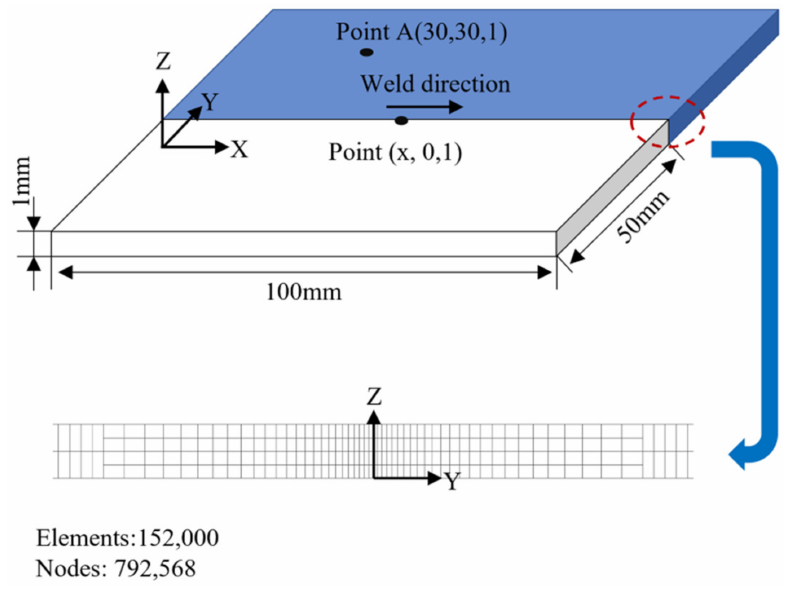
Figure 5. Mesh of FEM.